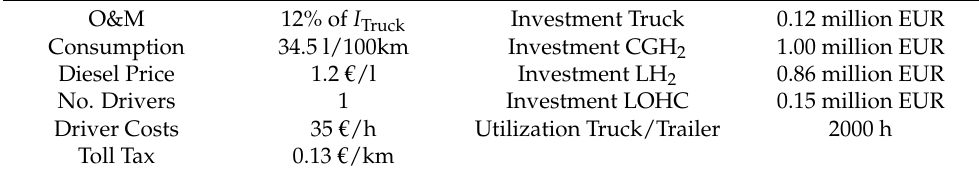
Table 2. CAPEX and OPEX assumptions. Own assumptions based on Reuss et al. [7]. O&M